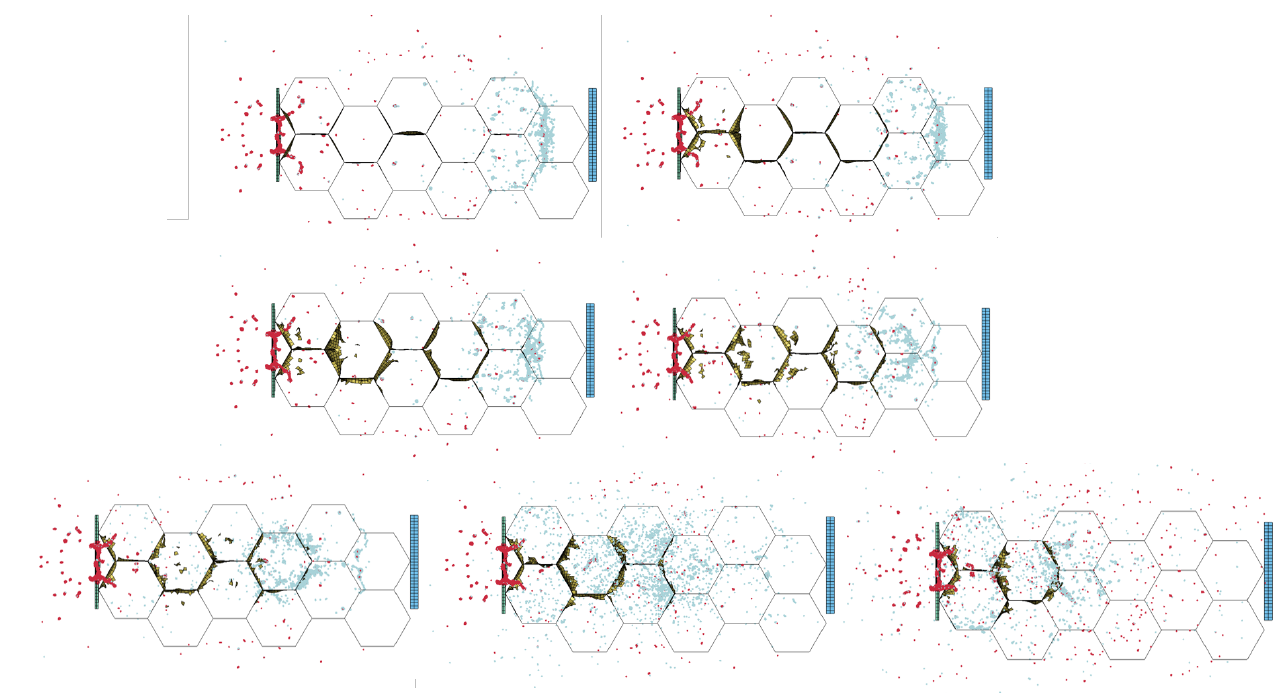
Figure 16. Simulation progress at 16.2 µ s for an increasing thickness of honeycomb core from top left (model T-01) to bottom right (model